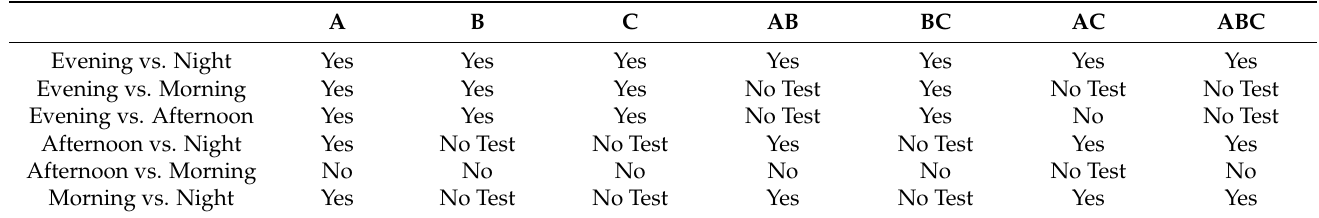
Table 2. Results of the analysis of variance (Student–Newman–Keuls Method) between different parts of the days in the number of particles for different channels. The significance threshold is p = 0.05. A result of “No Test” occurs when no significant difference is found between the two rank sums that enclose that comparison.